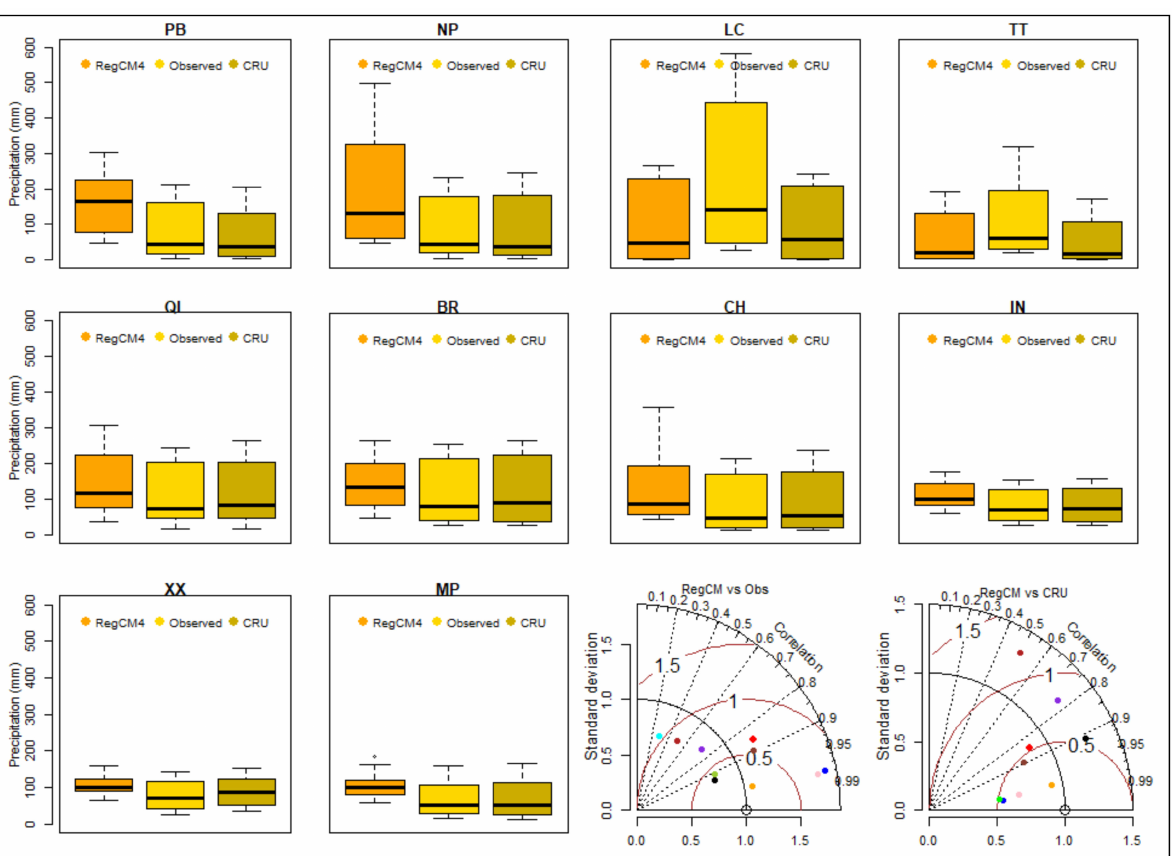
Figure 6. Boxplot diagrams for the three datasets, concerning to monthly mean of precipitation (mm/month) for reference period. In the lower right corner, Taylor diagrams for RegCM4 and WS (RegCM vs. OBS), CRU and WS (CRU vs. OBS). Open circle is the reference of normalized standard